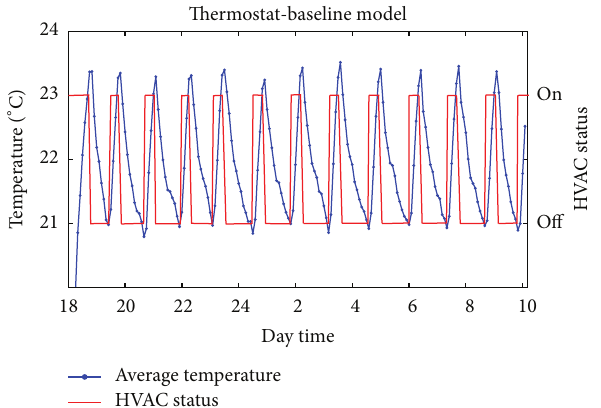
Figure 8: Experimental evaluation of the thermostat model.